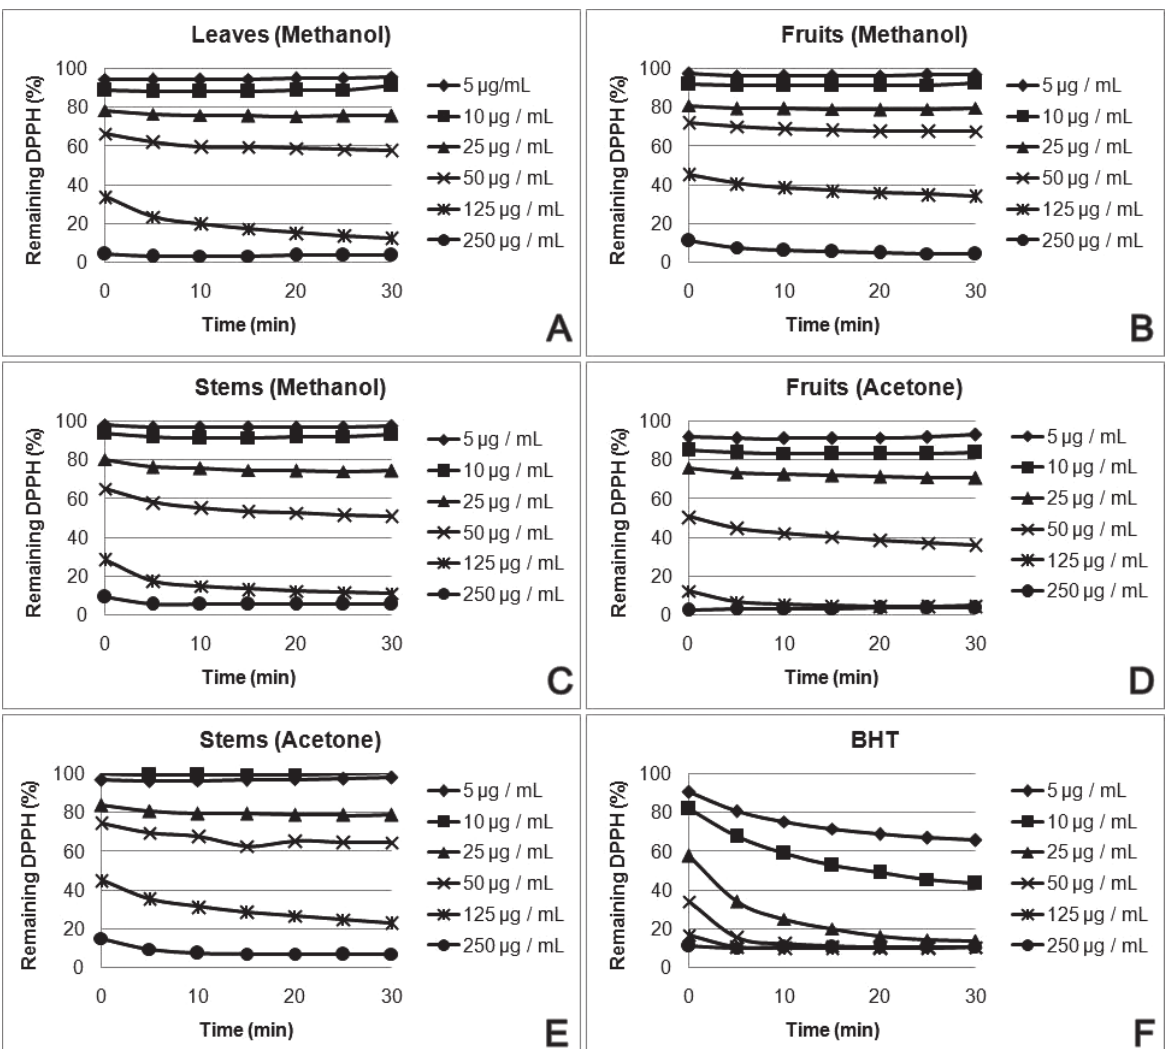
Fig. 1 - Reaction kinetics. (A) Methanolic crude extract of leaves of C. fluminensis with DPPH; (B) methanolic crude extract of fruits of C. fluminensis with DPPH; (C) methanolic crude extract of stems of C. fluminensis with DPPH; (D) acetonic crude extract of fruits of C. fluminensis with DPPH; (E) acetonic crude extract of stems of C. fluminensis with DPPH; (F) BHT with